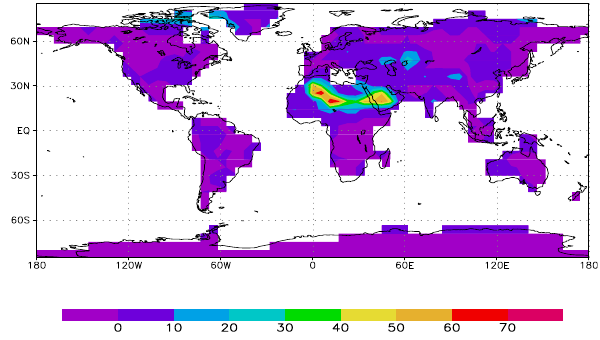
Fig. 20. Simulated difference in total vegetation cover (%) between the mid-Holocene and present-day conditions.